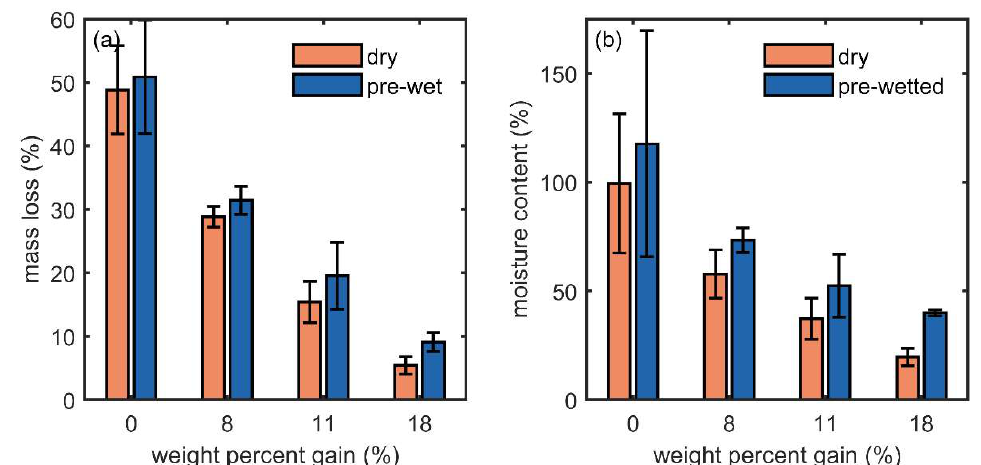
Figure 2. ( a ) mass loss and ( b ) moisture content as a function of percent weight loss from preliminary experiments where specimen pre-wetting was examined. The dry blocks had starting moisture contents (MCs) of less than 10%, and the pre-wetted blocks had starting moisture contents between 40% and 55%. Error bars represent the standard deviation from 5 replicates.